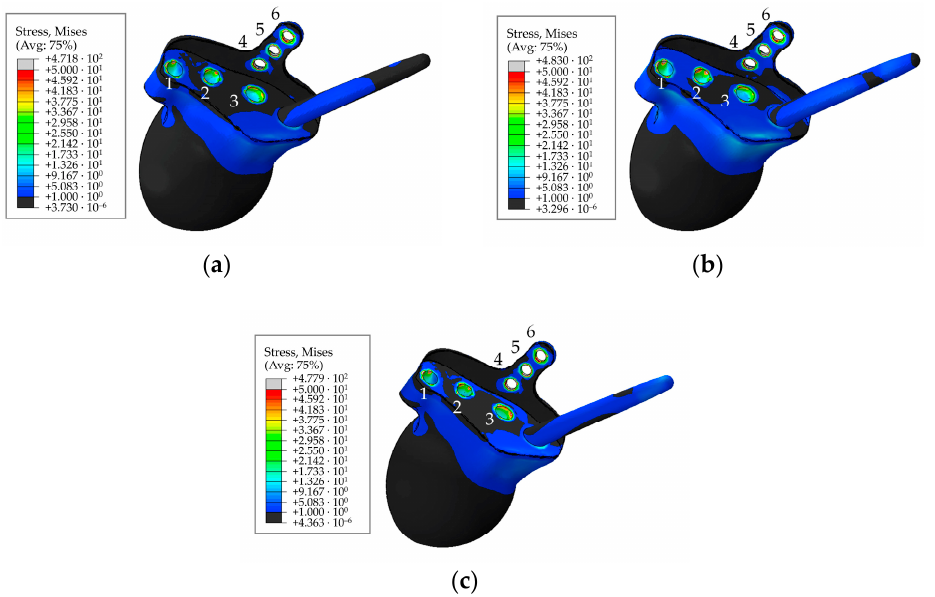
Figure 20. Stress distribution in implant for a pretension force of 500 N and the hole numbering convention: ( a ) In 63% phase; ( b ) for ascending stairs; ( c ) for descending stairs, MPa.